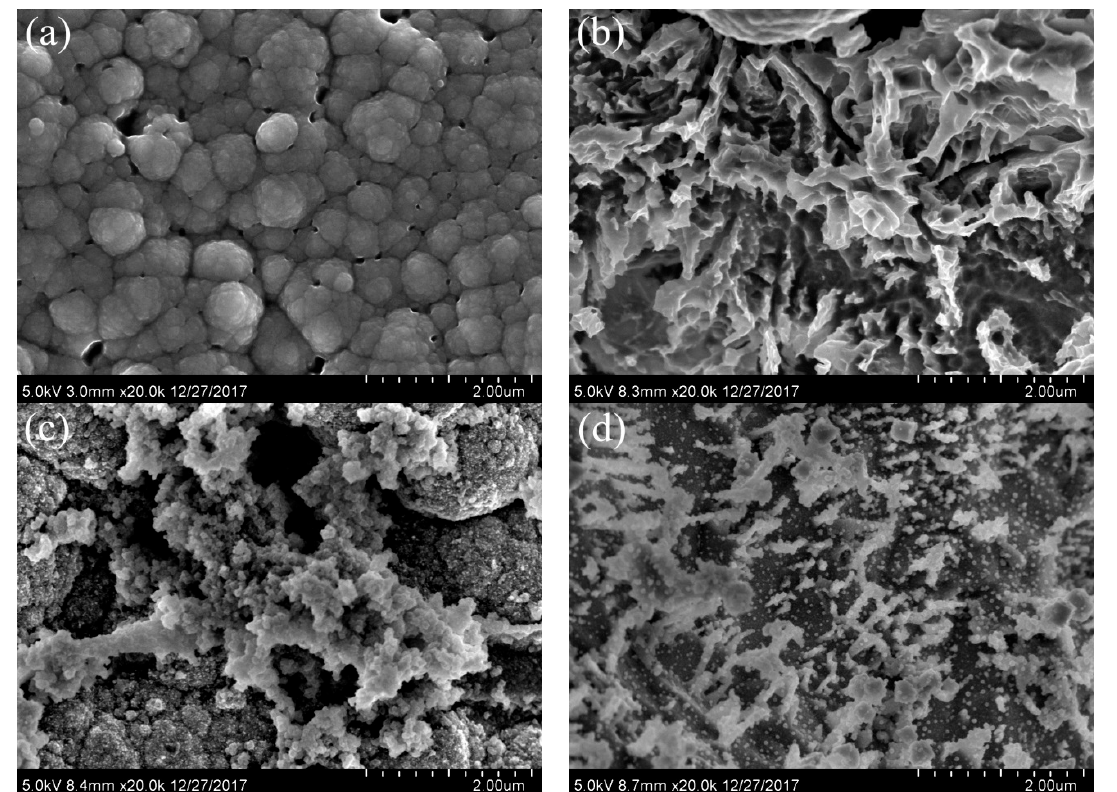
Figure 3. SEM images of the modified electrodes: ( a ) PPY/Ti electrode; ( b ) PPY/Ti electrode after fluorination; ( c ) PPY/Ti electrode after fluorination, sensitization, and activation; ( d ) Pd-Ag/PPY/Ti electrode.